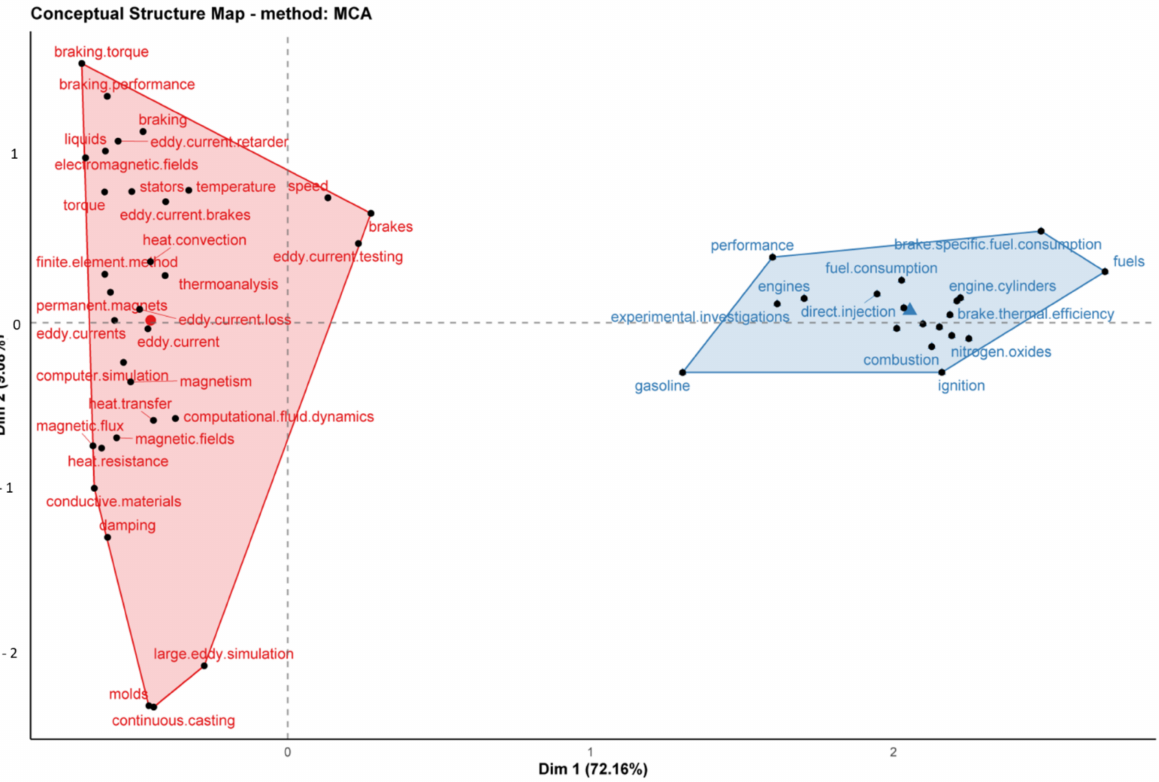
Figure 15. Conceptual structure